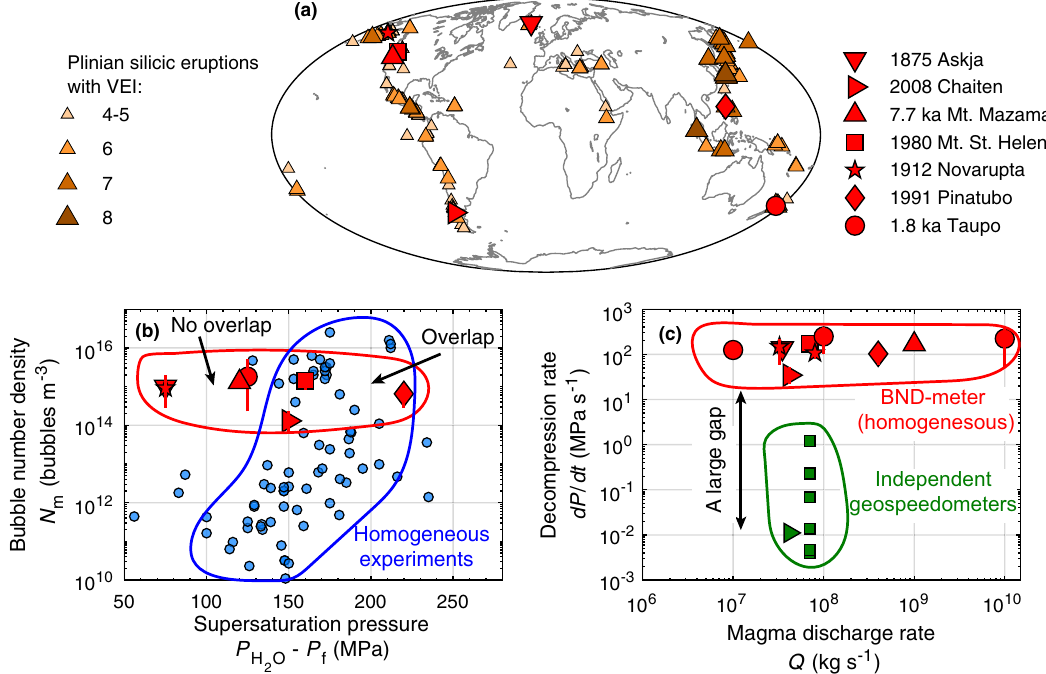
Fig. 1 Plinian silicic eruptions, their observed bubble number densities, and their inferred decompression rates. a Spatial distribution of Plinian (Volcanic Explosivity Index ≥ 4) silicic eruptions over the past 100 kyr, based on Crosweller et al. 2 . Red symbols are eruptions for which bubble number density and H 2 O saturation pressure are documented. They are: 1875 Askja 40,41 ; 2008 Chaiten 42,43 ; 7.7 ka Mount Mazama 44,45 ; 1980 Mount St. Helens (MSH) 46 – 48 ; 1912 Novarupta 49,50 ; 1991 Pinatubo 51,52 ; 1.8 ka Taupo 53 eruptions. b Bubble number density versus the maximum potential H 2 O supersaturation pressure for eruptions (red symbols) and for homogeneous nucleation experiments (blue symbols) 10,12,19,32,54 – 59 . Only experiments with supersaturation pressure of ≥ 150 MPa overlap with eruptions. c Decompression rate values estimated from observed bubble number density and homogeneous nucleation 17 . There is a large gap between these estimates and those calculated by independent geospeedometers for the same eruptions 43,60 – 64